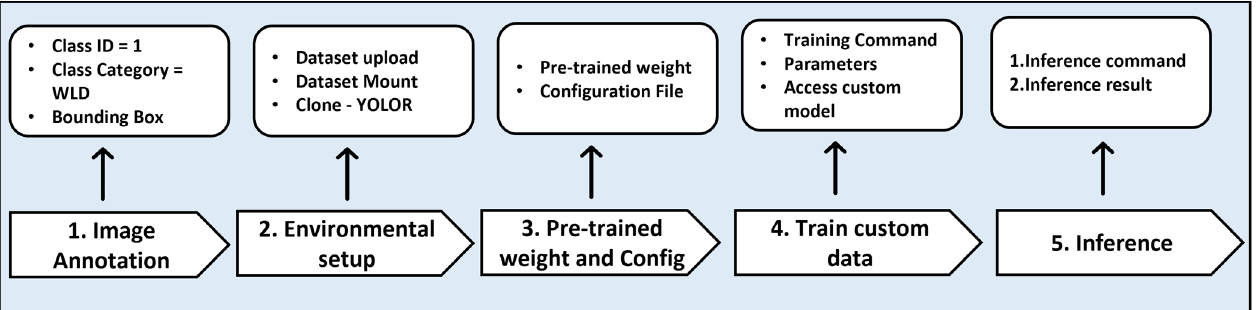
Figure 6. Main steps in the development of YOLOR model.